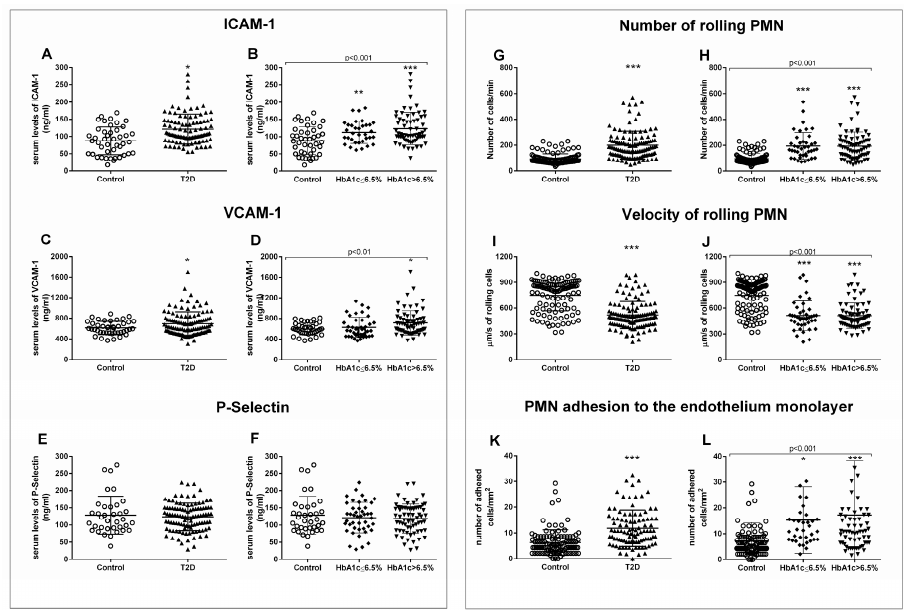
Figure 2. Serum levels of soluble adhesion molecules and measurement of PMN–endothelium interactions . Di ff erences in adhesion molecules between control and T2D groups ( A , C , E ) or between control, well-controlled diabetics (HbA 1c ≤ 6.5%), and poorly controlled diabetics (HbA 1c > 6.5%) ( B , D , F ) are shown. The number of rolling cells ( G , H ), their velocity ( I , J ), and the adhesion of these cells to the endothelial monolayer ( K , L ) were analyzed. Di ff erences between control and T2D groups ( G , I , K ) or between control, well-controlled diabetics (HbA 1c ≤ 6.5%), and poorly controlled diabetic groups (HbA 1c > 6.5%) ( H , J , L ) are shown. Statistical analysis was performed by means of a t -test to compare two groups, and using ANOVA with Bonferroni post-test for three groups. * p < 0.05; ** p < 0.01; *** p < 0.001 vs. control.